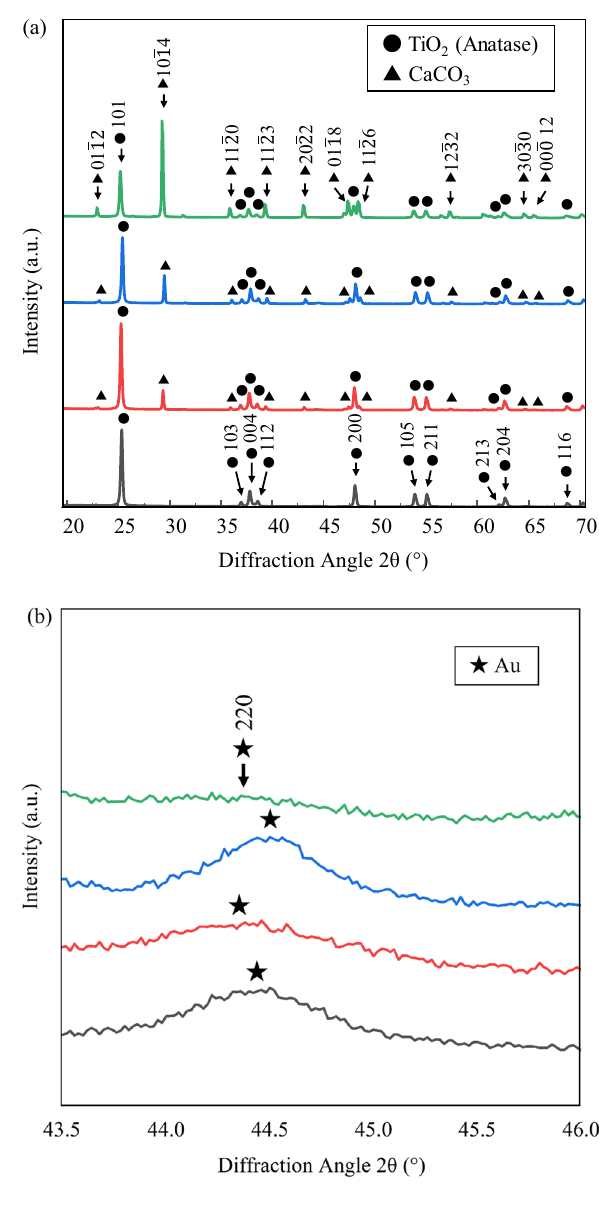
Fig. 2 X-ray diffraction patterns of the prepared AuNP/TiO (X g) catalysts, X = 0 g: black, 0.4 g: red, 0.8 g: blue, 4.0 g: